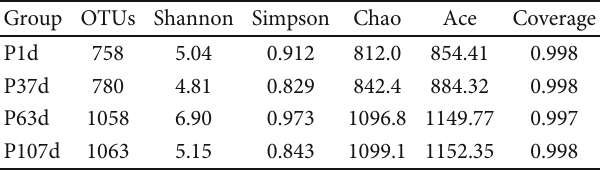
Table 2: Characteristics of amplicon